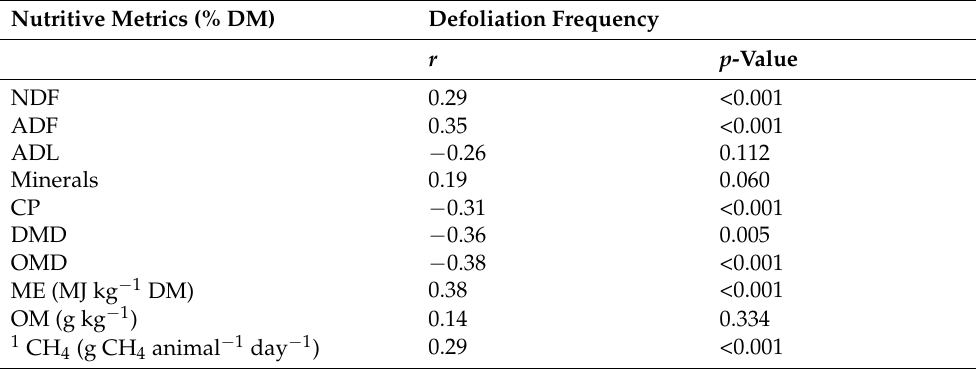
Table 3. Pearson correlation coefficients (r) between tropical forage nutritive values and estimated methane production vs. defoliation frequency in the database.